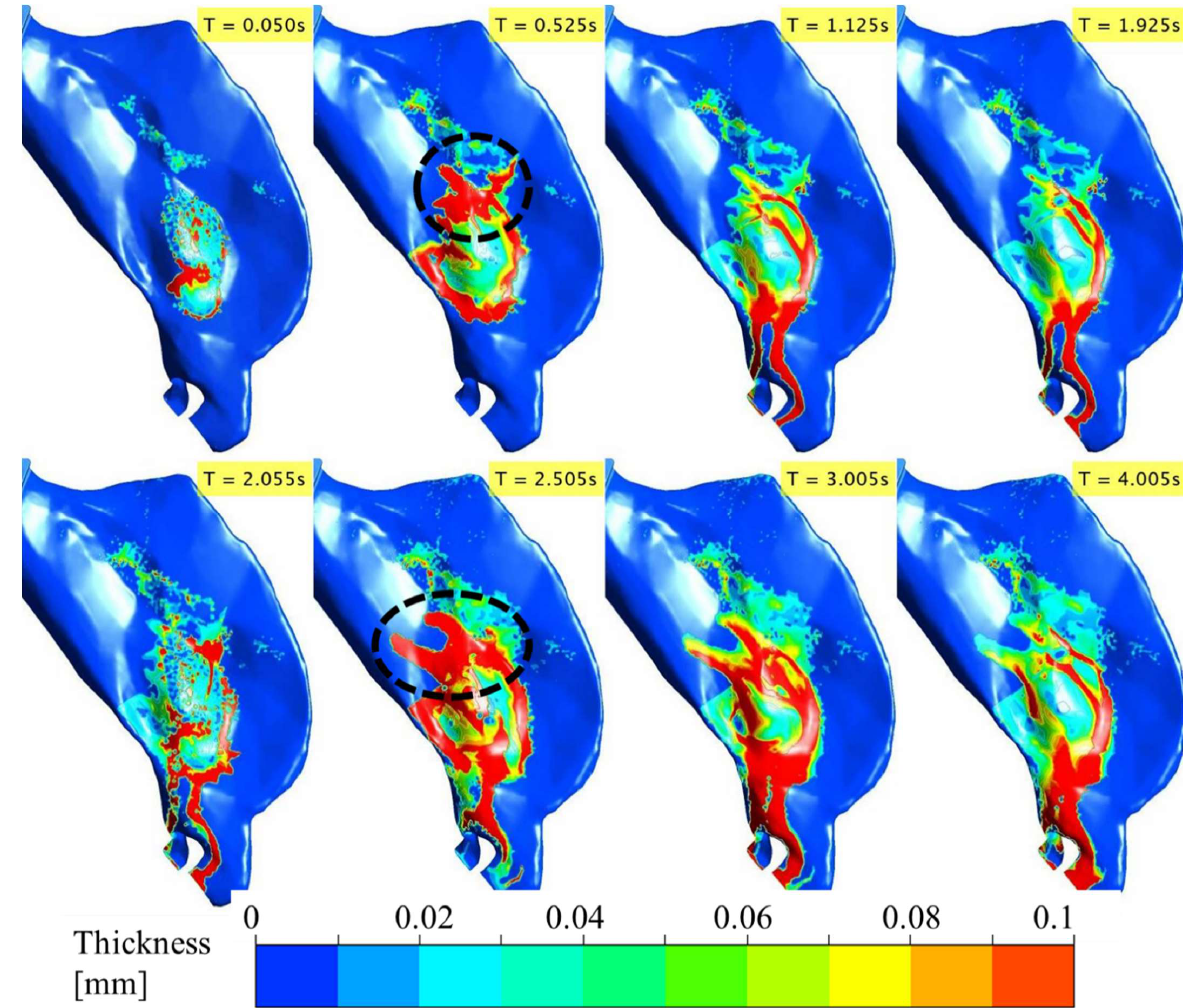
Figure 4. Evolution of the deposited Flonase liquid on the nasal airway surface during the two spray actuation cycles at specific time points noted in the upper right corner of each sub-figure panel. (Dotted circle represents the high liquid mass concentration in the posterior region).